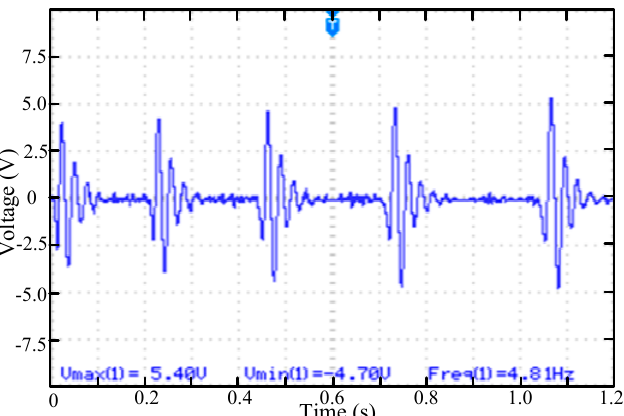
Figure 6. The voltage waveform of the piezoelectric beam while rotating mass block rotates with a permanent magnet (position 1).